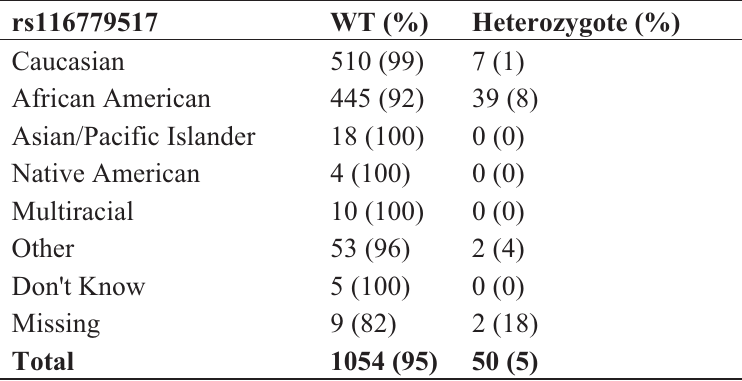
Figure 2. Representative nucleotide sequencing of the non-bisulfite modified genomic DNA for n = 14 variant cervical tissue specimens, n = 2 WT cervical cancer specimens and n = 6 cord blood specimens. The non-variant ( top ) and variant ( bottom ) nucleotide sequences of the IGF2 DMR region are shown. The three CpG sites comprising this DMR are designated at the top and the position of SNP G > C rs116779517 is indicated by the arrow. Table 1. Newborn Epigenetics Study.